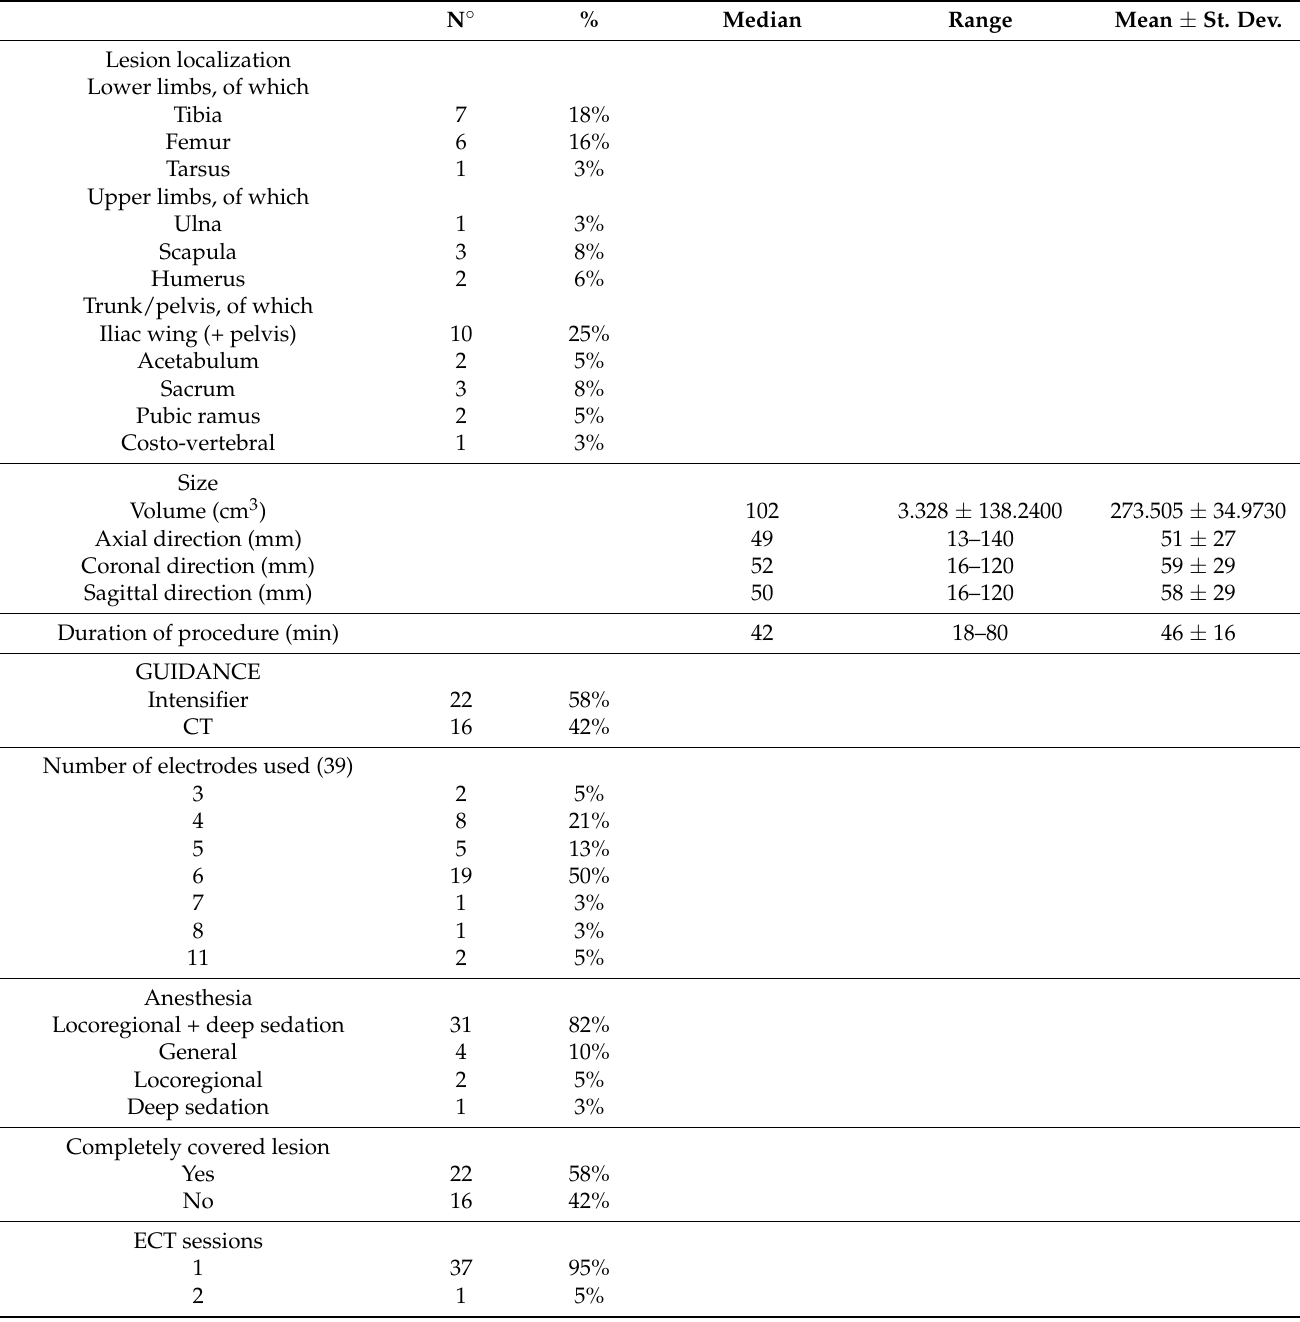
Table 2. Detailed description of treated lesions and ECT